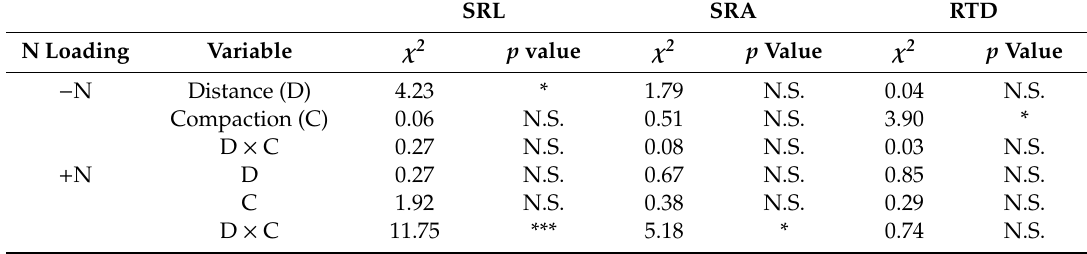
Table 3. Summary of ANOVA for responses of root morphological traits, specific root length (SRL), specific root area (SRA), and root tissue density. (RTD) without N loading ( − N) and with N loading